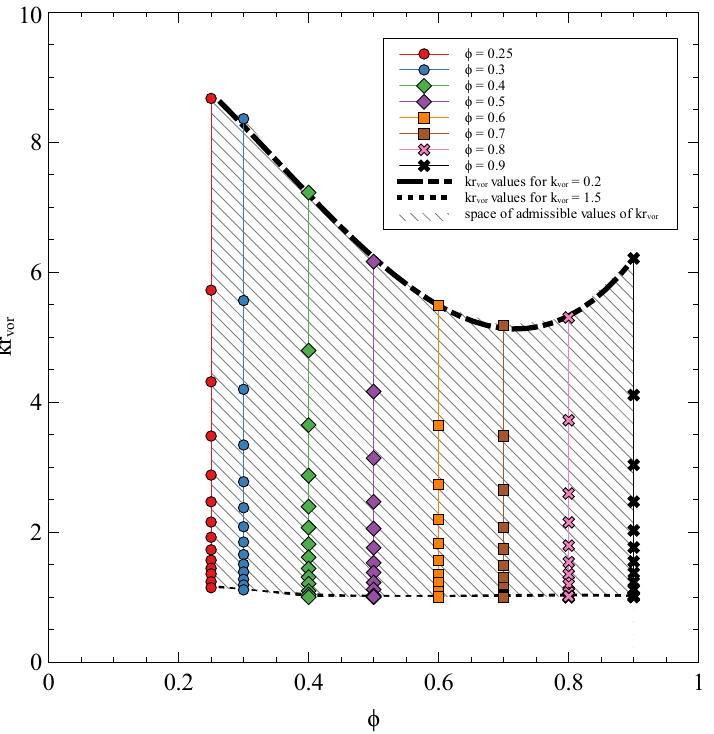
Figure 18. Space of admissible solutions of ( k vor , kr vor )